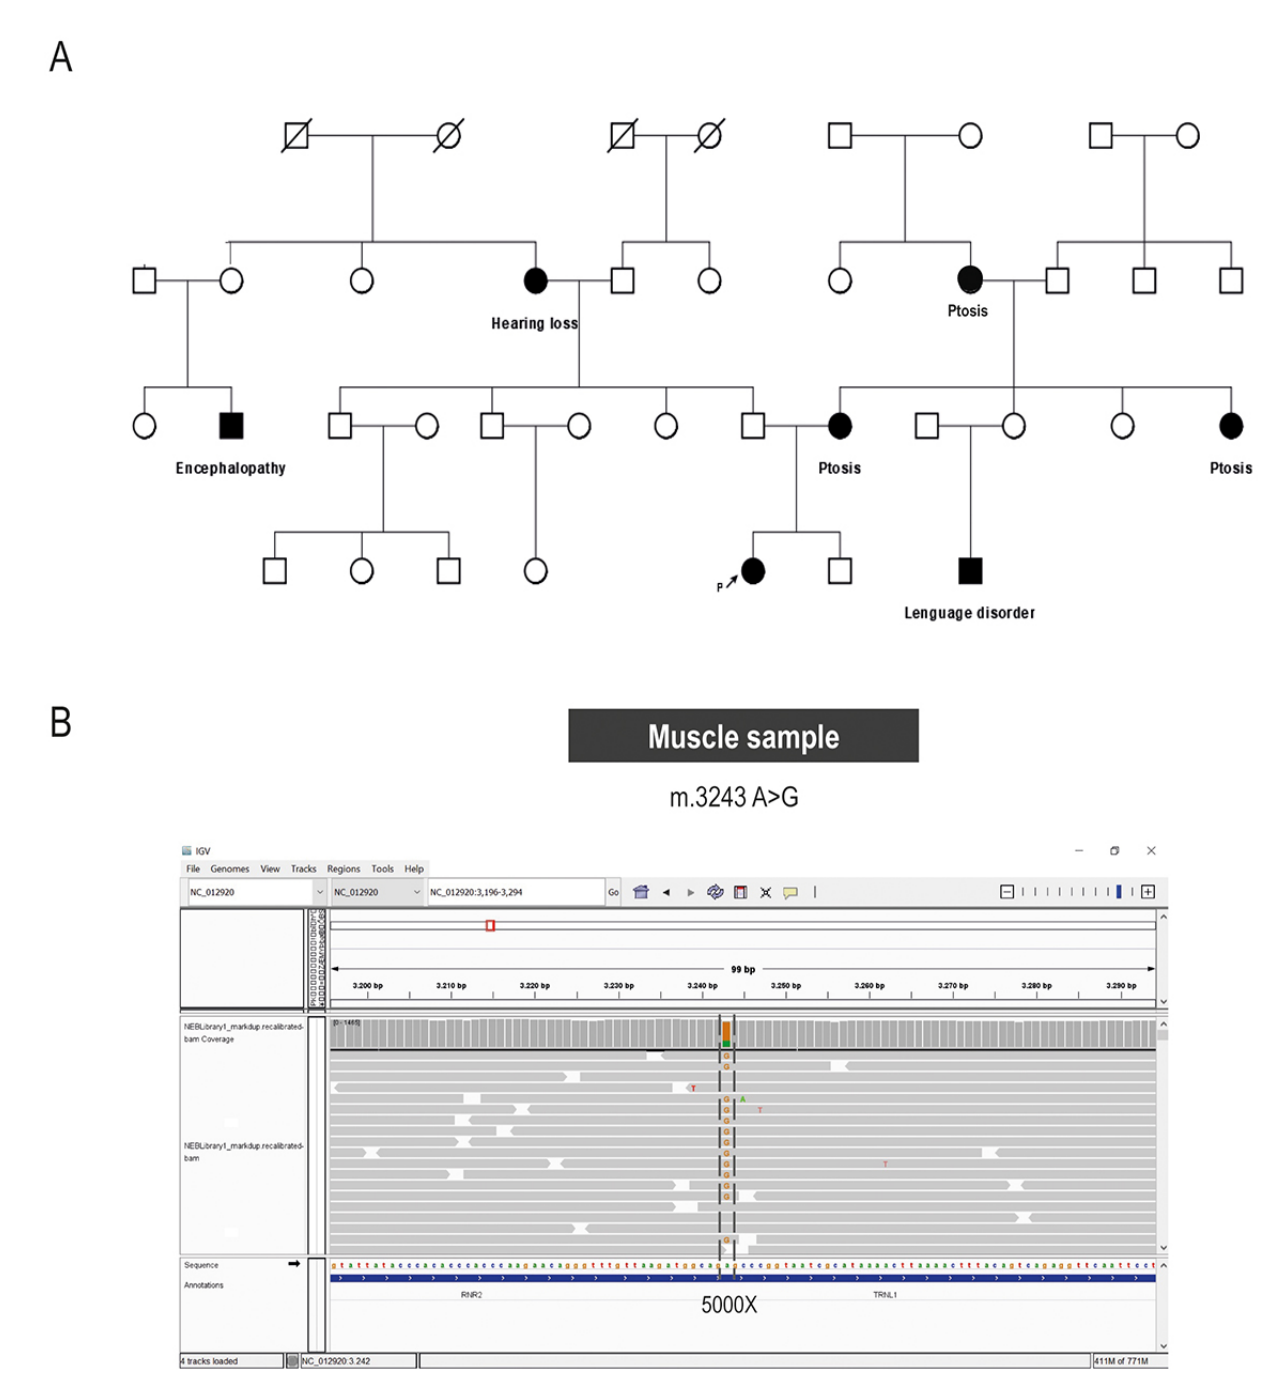
Figure 3. (a) Pedigree Chart. Arrow indicates index case (b) Alignment showing identified variants in the patient with a median sequence coverage of